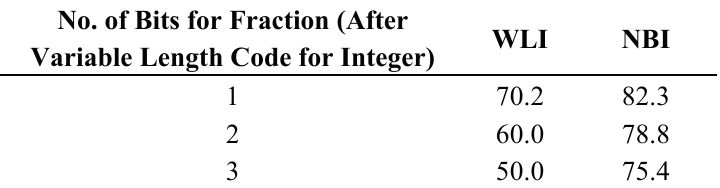
Table 6. Compression ratio (CR %) at different bit